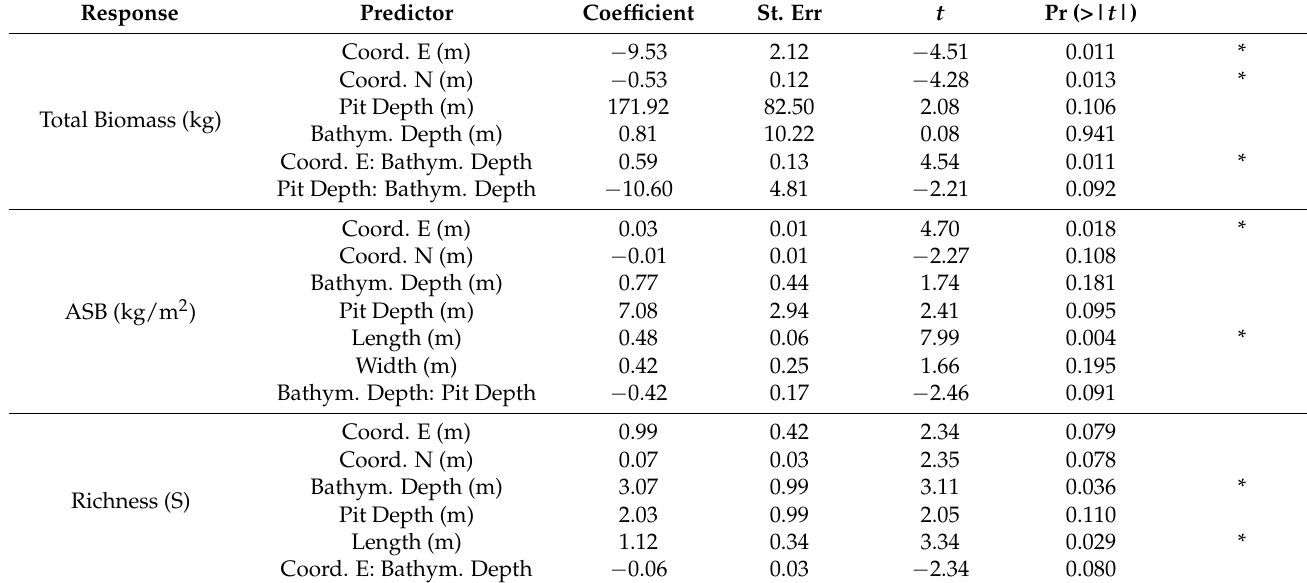
Table 4. Multiple regression analysis to predict if ice pit dimensions and relative position were good predictors of biological metrics. ASB: Area Specific Biomass.